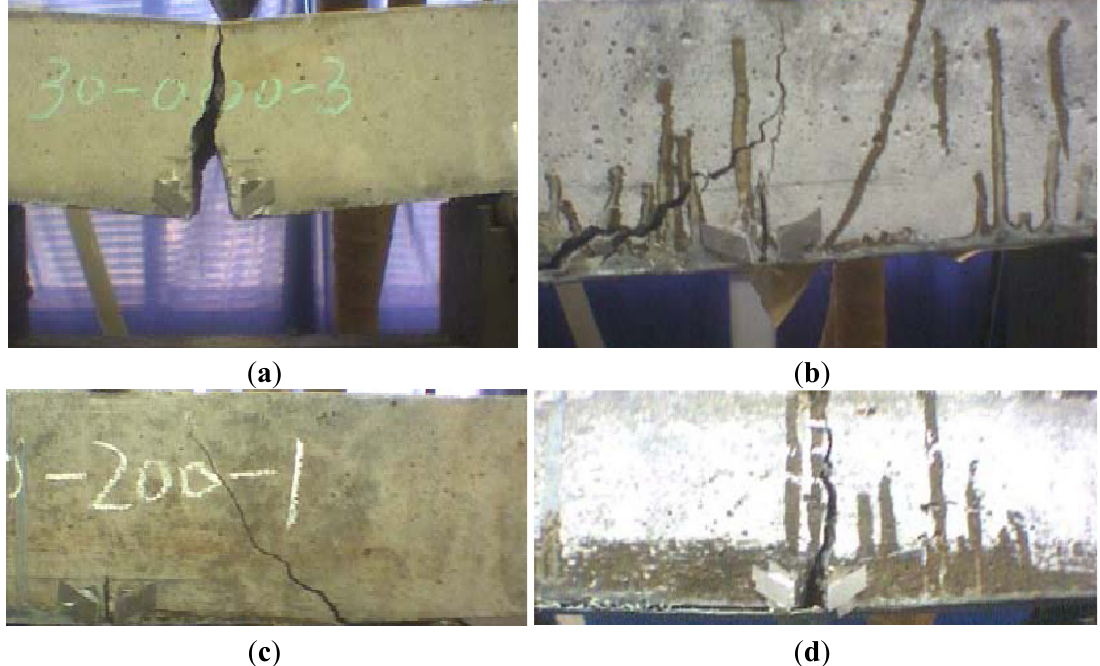
Figure 5. The failure mode in experimental observation: ( a ) failure mode of the beam without CFRP; ( b ) failure mode of the beam with CFRP of 0.10 m; ( c ) failure mode of the beam with CFRP of 0.20 m; and ( d ) failure mode of the beam with CFRP of 0.35